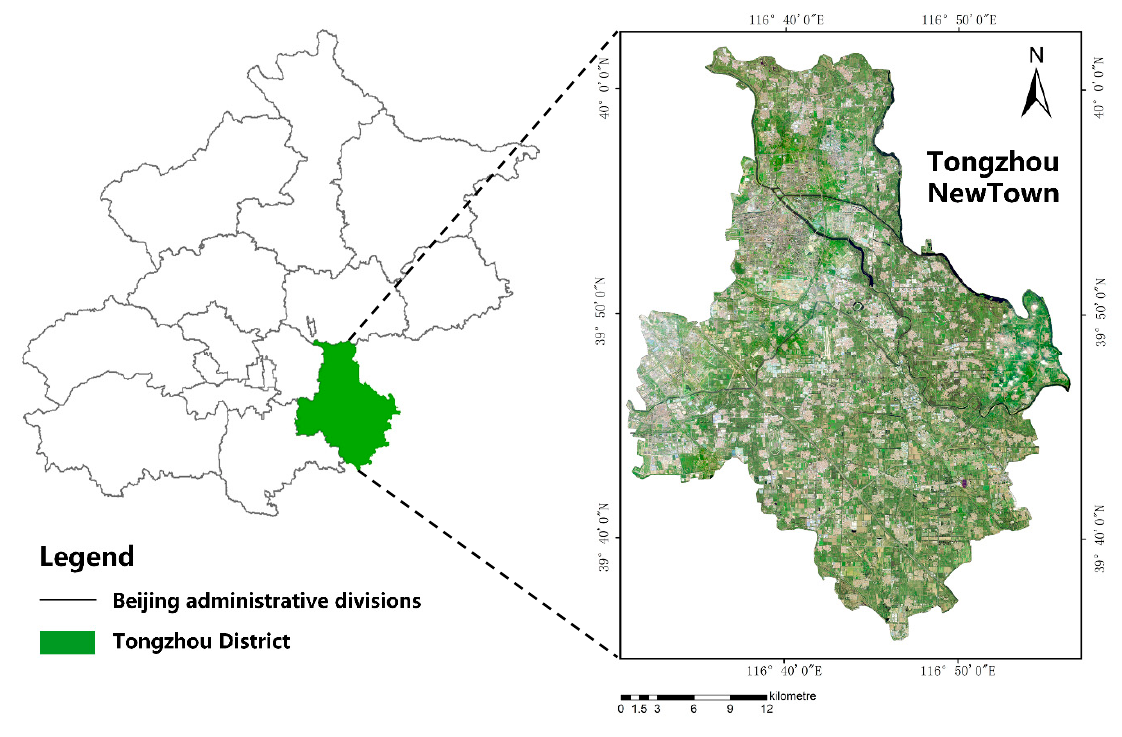
Figure 1. Study area.